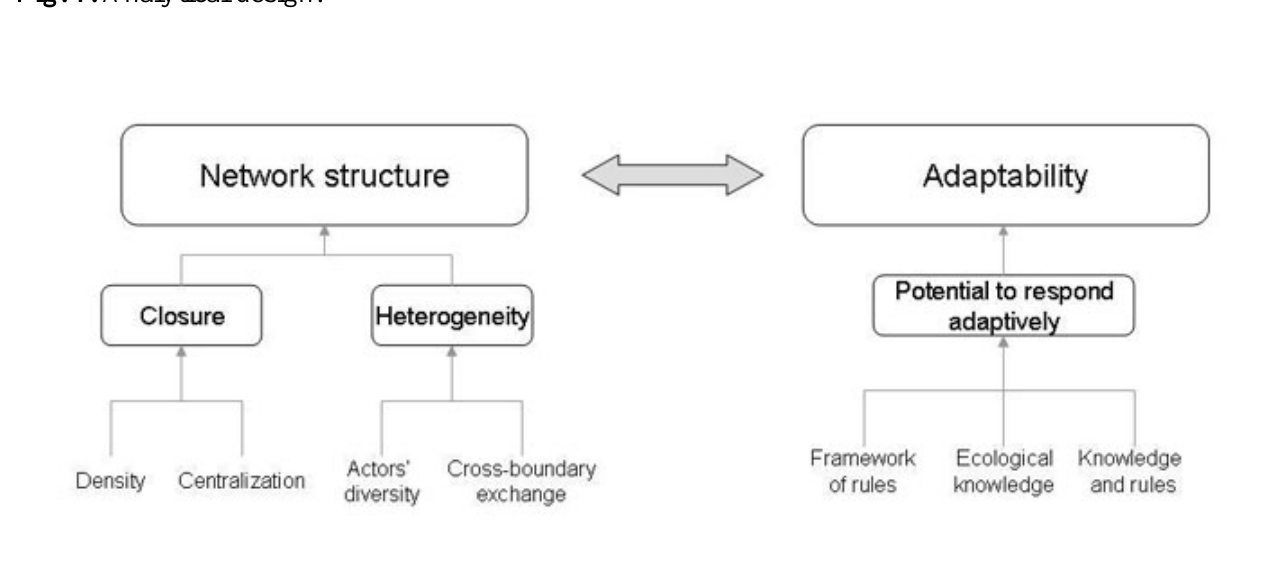
Fig. 1. Analytical